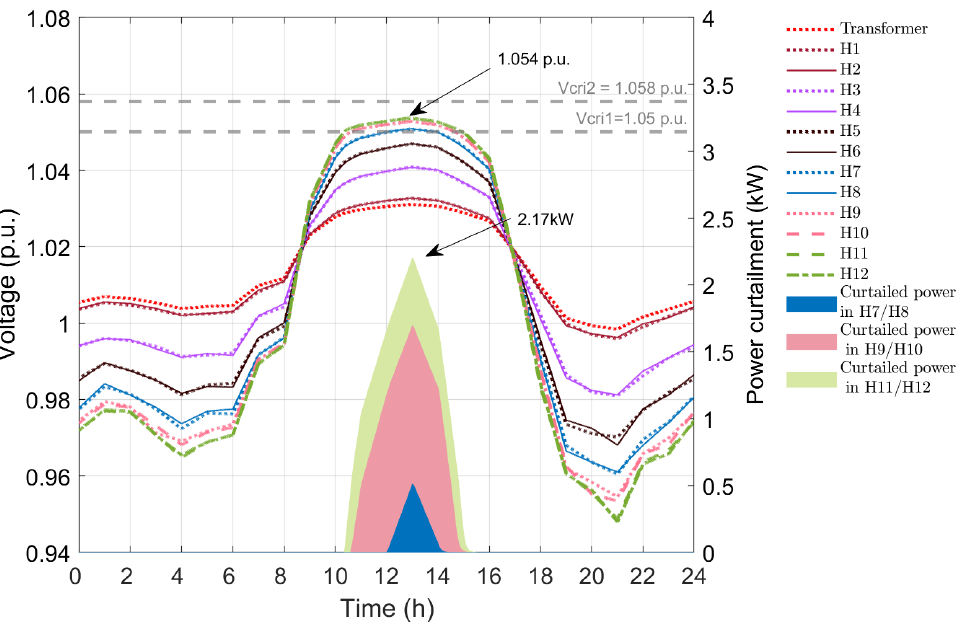
Figure 8. Voltage profile of twelve houses (House 1 to House 12) and curtailed power in APC method with linear